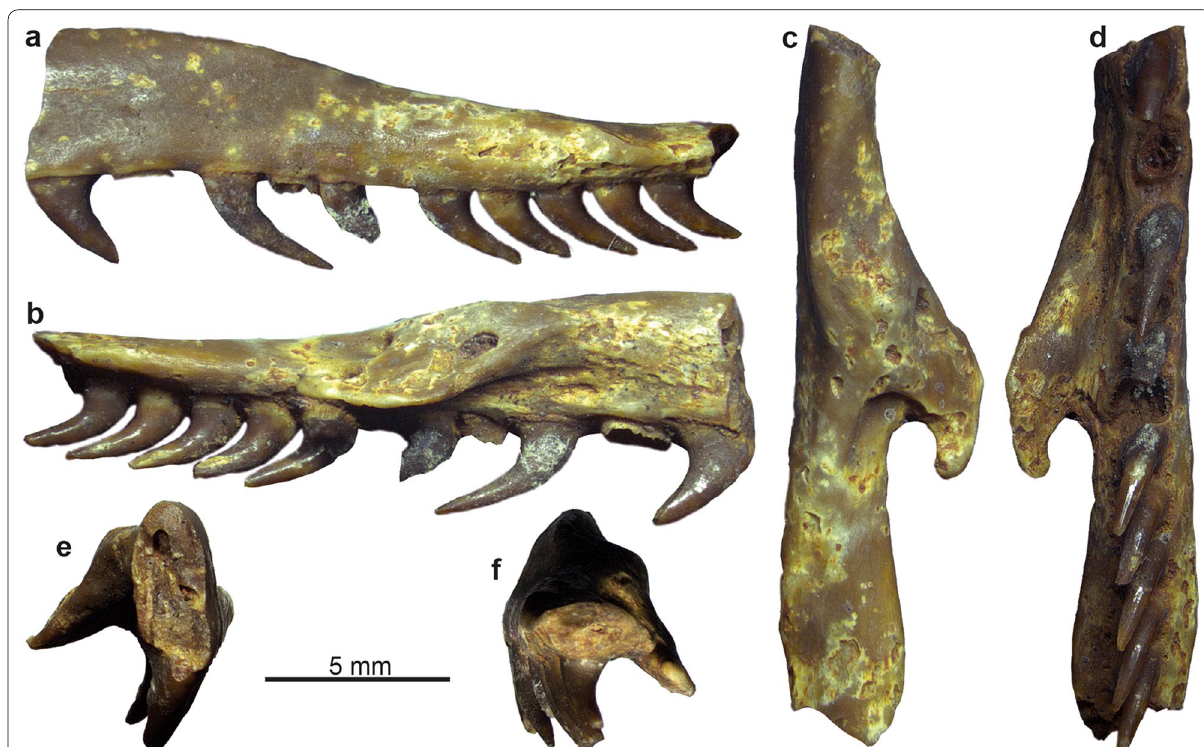
Fig. 96 Phosphoroboa filholii comb. nov. from an imprecisely known locality in the Phosphorites du Quercy: left maxilla (NHMW 2019/0020/0001) in